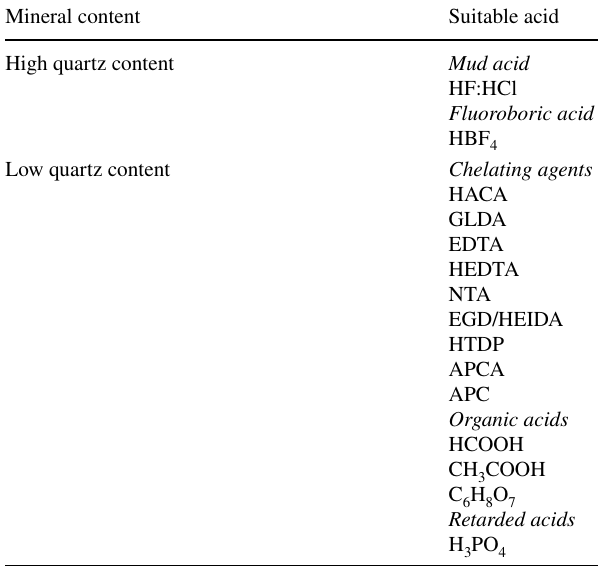
Table 12 Alternatives acids for high- and low-quartz content sand-